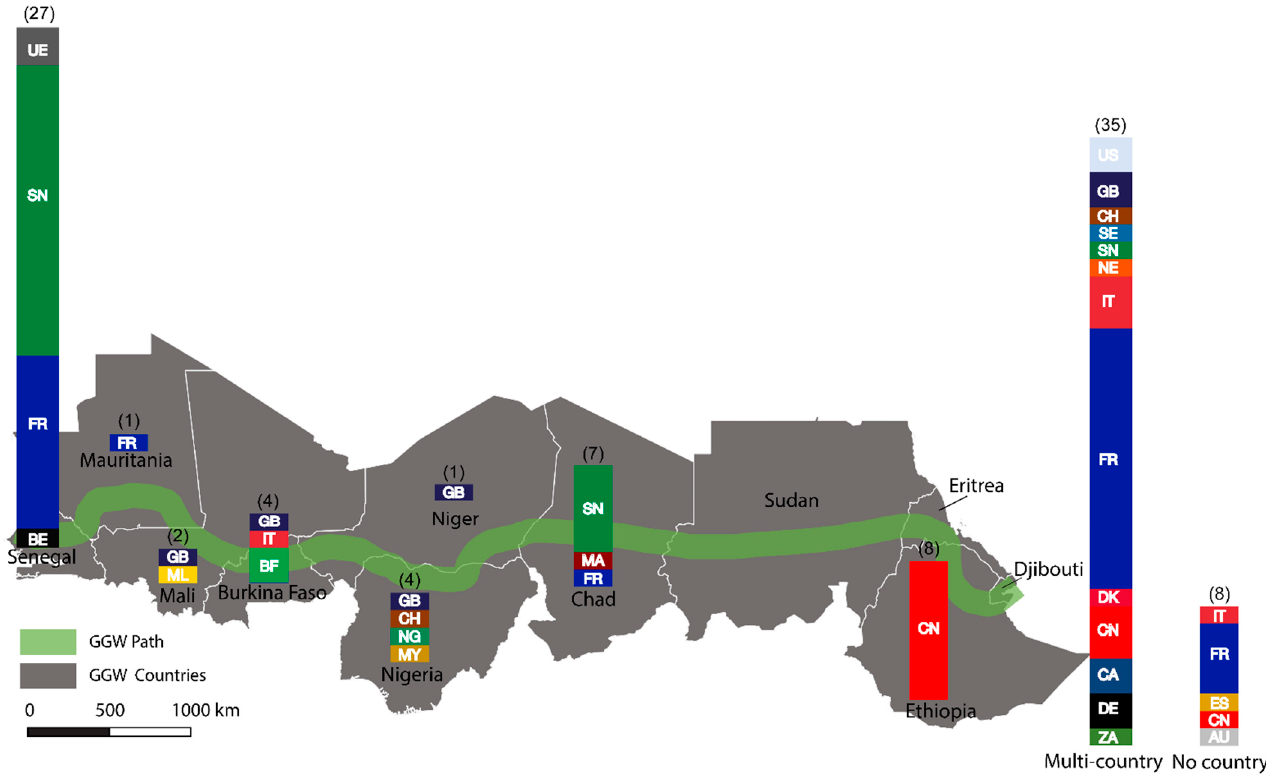
Figure 3. Map of SGGW studies and country of the first author associated. Country names are defined by the ISO3166 standard.